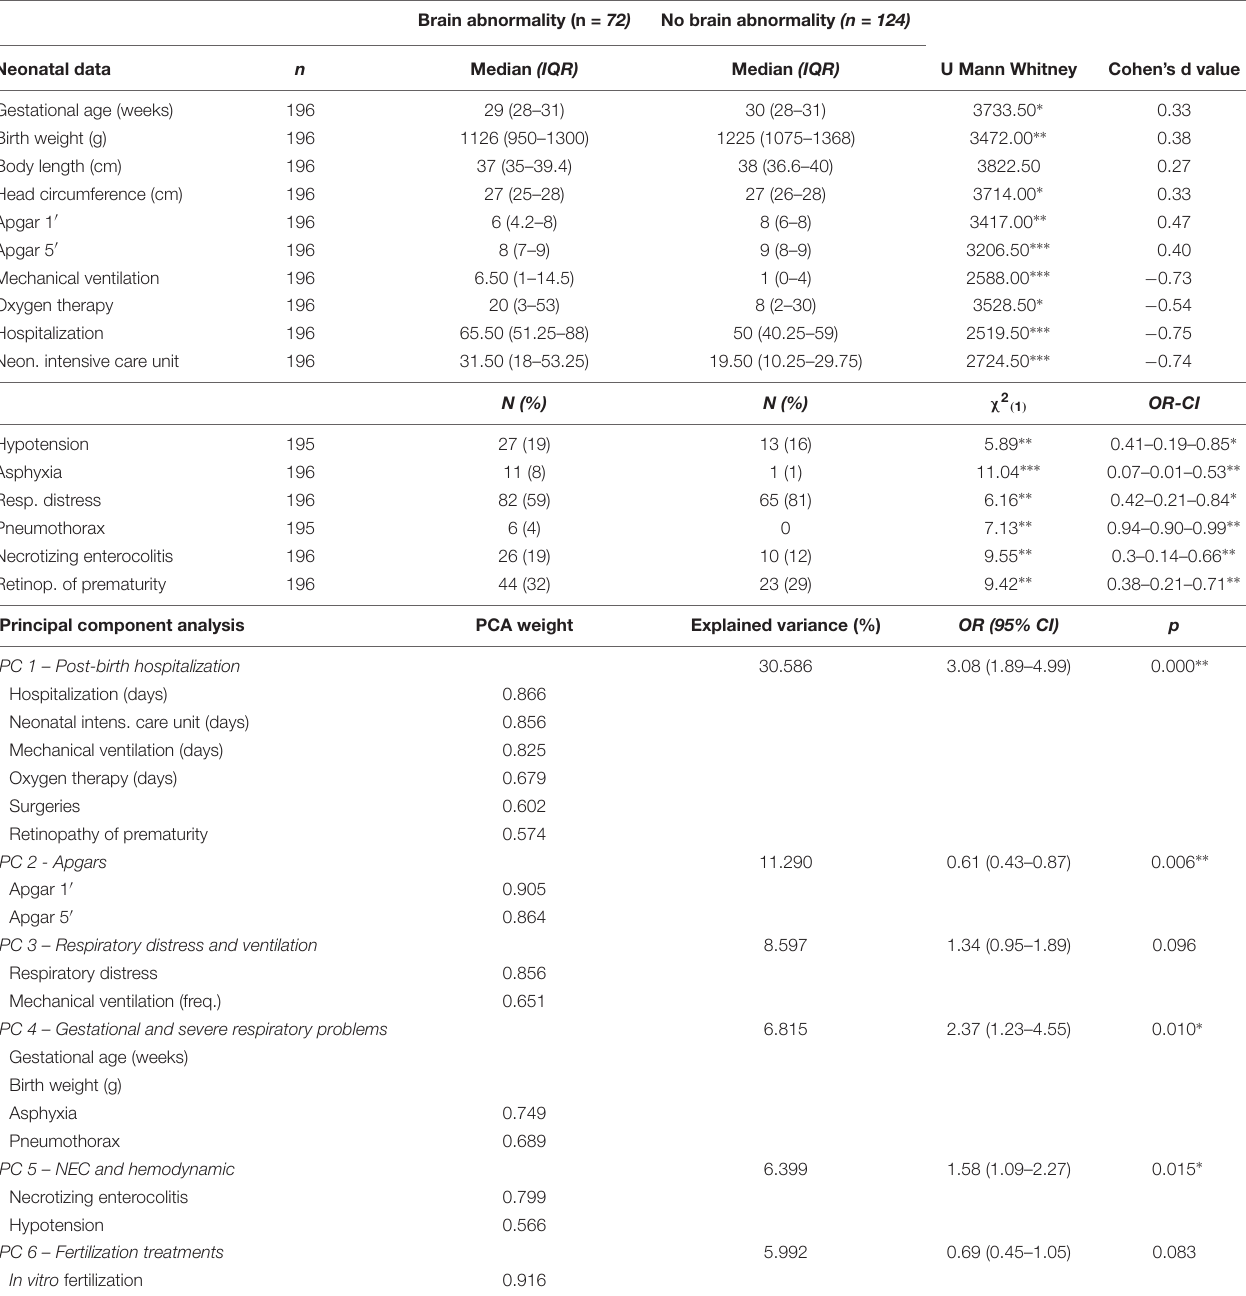
TABLE 2 | Neonatal data of babies born very preterm/very low birth weight with presence/absence of ultrasound brain abnormalities. Summary of results from the principal component (PCA) and the multivariate logistic regression analyses. Brain abnormality (n = 72) No brain abnormality (n =